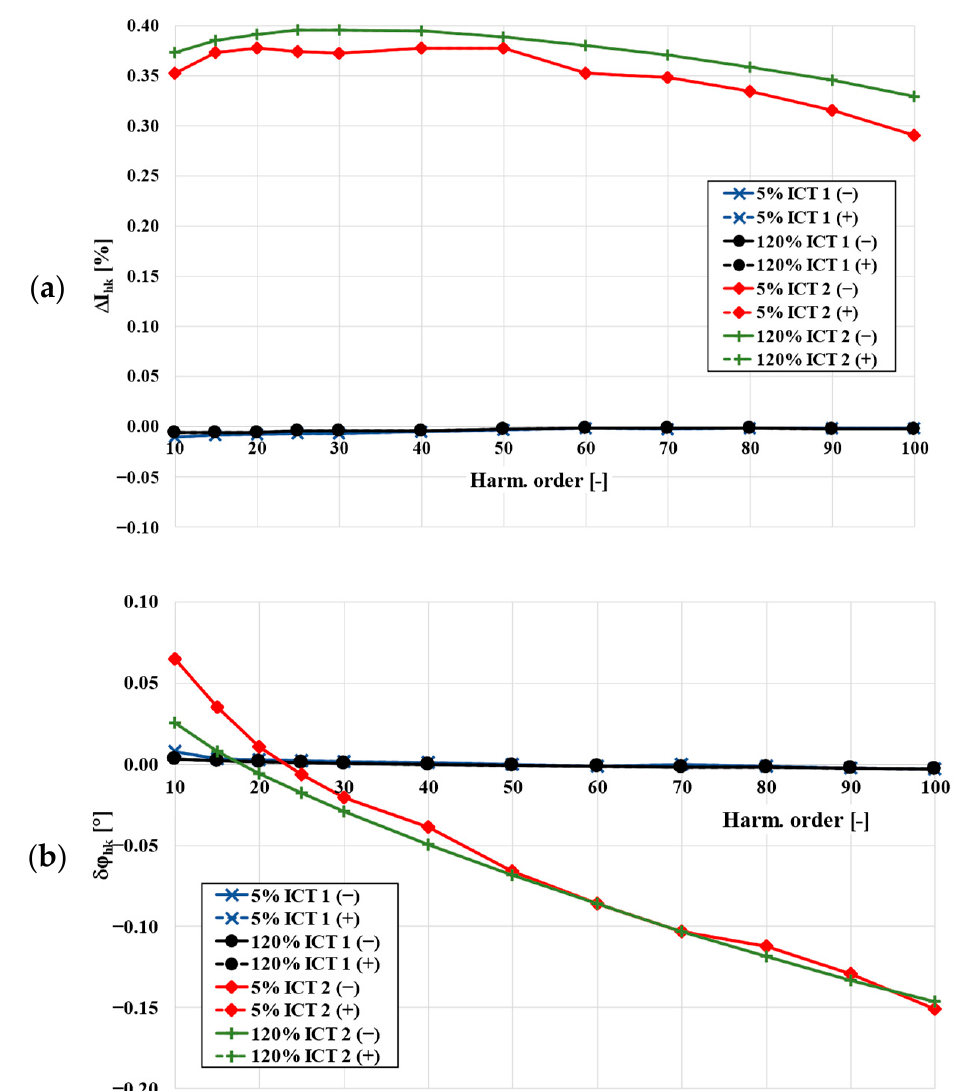
Figure 6. Comparison of determined values of the current error ( a ) and phase displacement ( b ) for both tested CTs up to 100th higher harmonic and 25% of the rated load of the secondary winding.